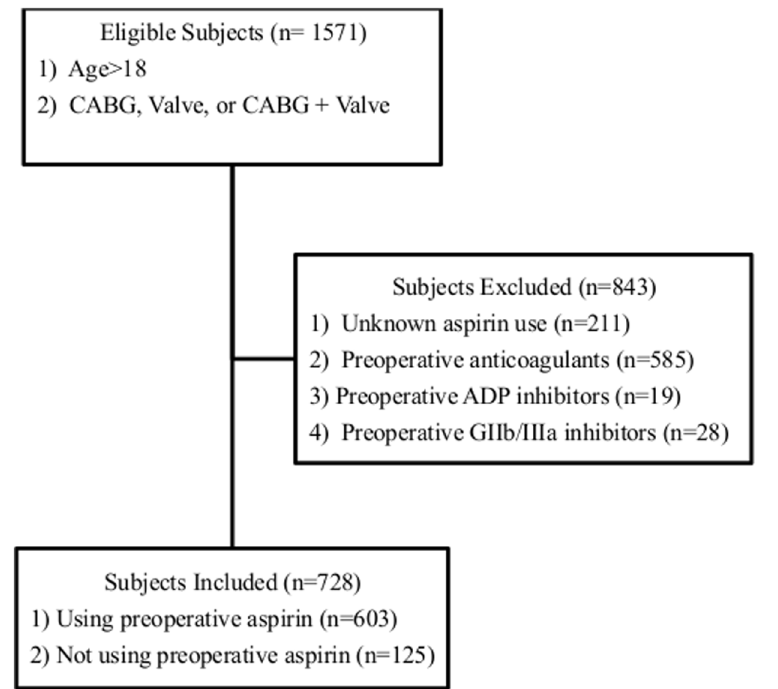
Fig 1. Study Inclusion/Exclusion